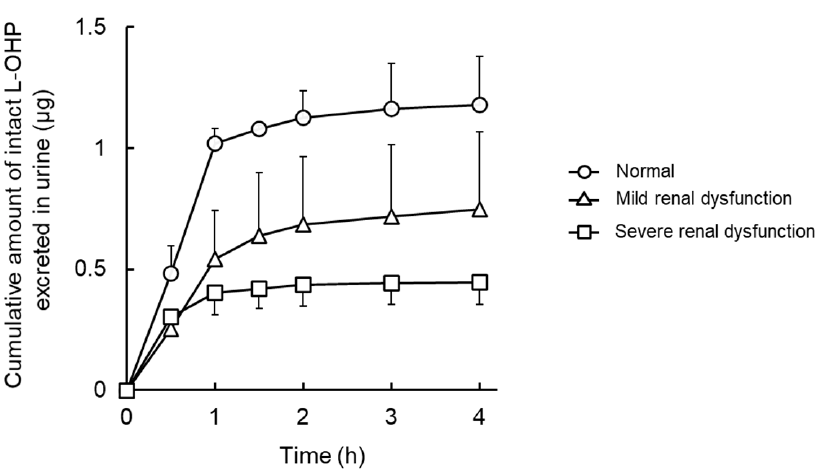
Figure 2. Mean cumulative urinary excreted amounts of oxaliplatin (L-OHP) versus time after intravenous administration of 8 mg/kg of L-OHP in normal, mild, and severe renal dysfunction model rats. Each symbol represents normal ( ○ ), mild ( △ ), or severe renal dysfunction ( □ ) groups. Each point shows the mean ± S.D. ( n = 3–4). Table 2. Non-compartmental pharmacokinetic parameters of oxaliplatin (L-OHP) in normal, mild, and severe renal failure model rats.